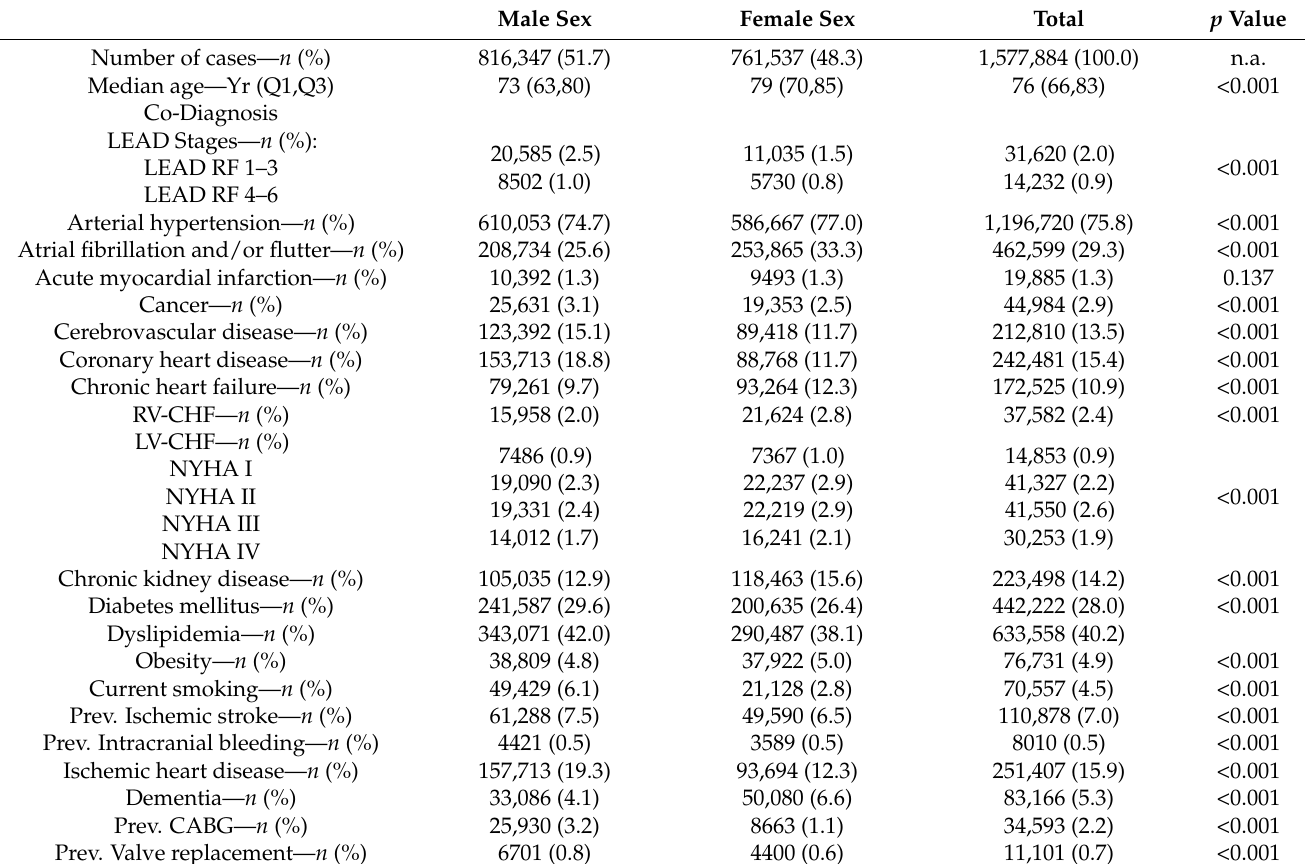
Table 1. Baseline characteristics of patients hospitalized with ischemic stroke from 2014 to 2019. Female Sex Total p